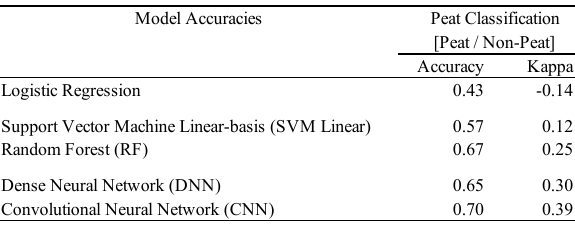
Table 4 . Modeling accuracies attained on validation data.